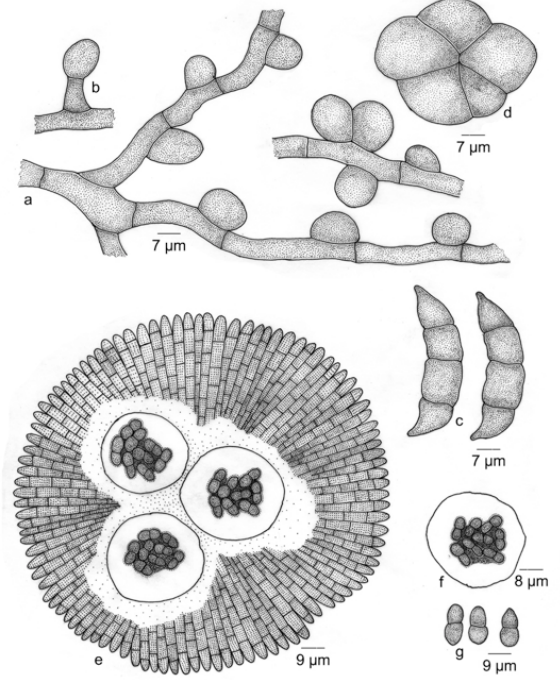
Figure 189. Schiffnerula brideliae a - Appressoriate mycelium; b - Conidiophore; c - Conidia of Questieriella ; d - Conidia of Sarcinella ; e - Thyriohtecium; f - Ascus; g - Ascospores Figure 190. Schiffnerula camelliae